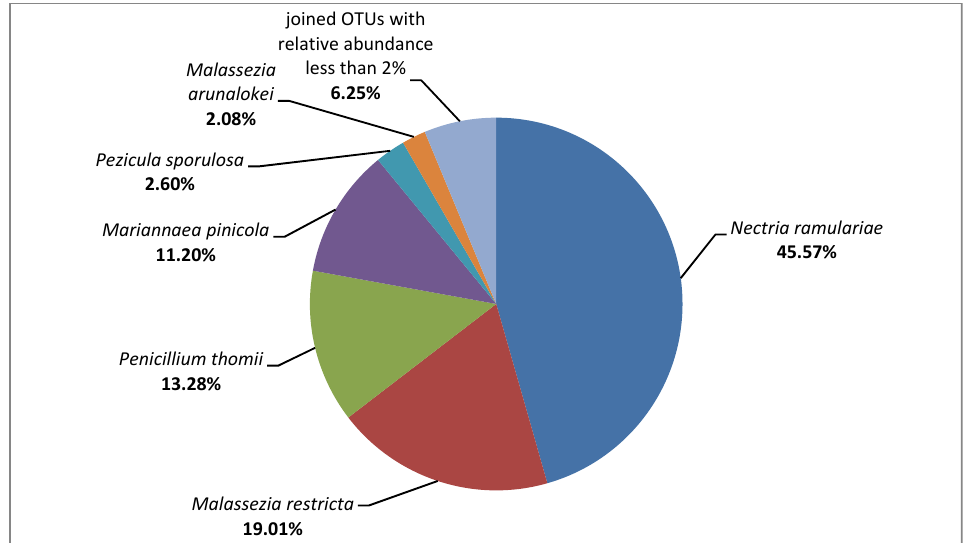
Figure 3. Identification results of the fungi isolated from the composite surfaces, using the NGS method.